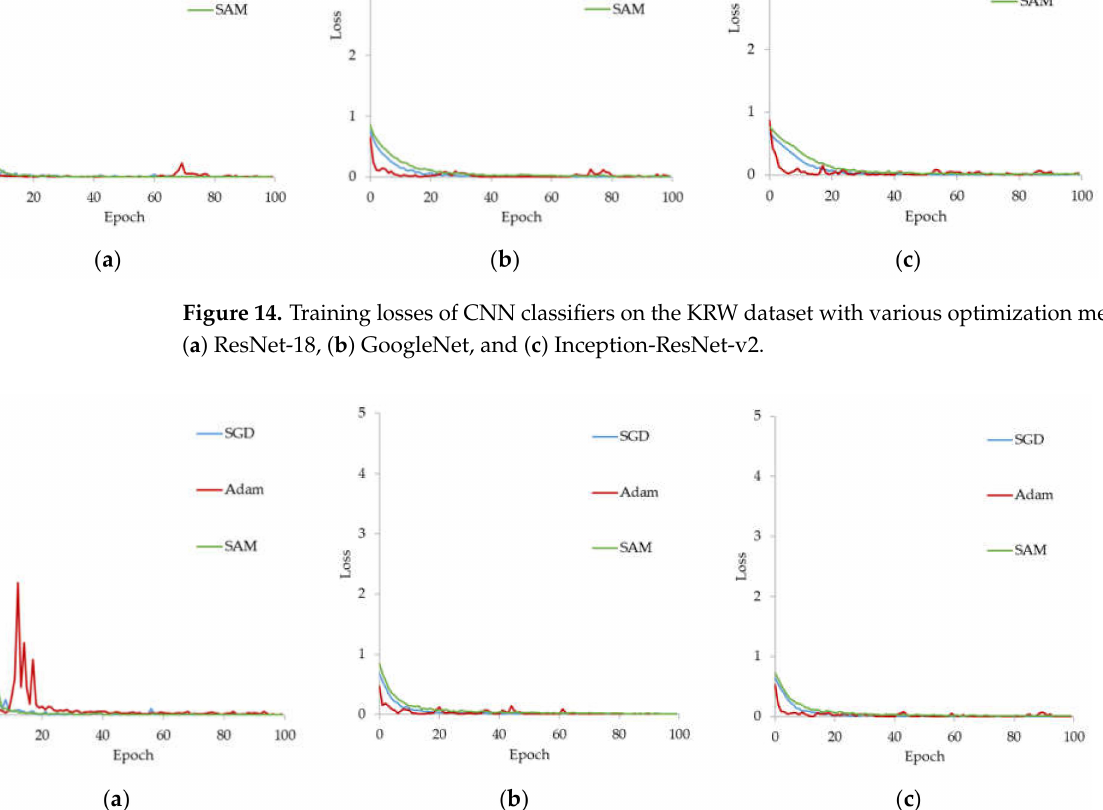
Using the trained CNN models, we tested the remaining (different) datasets and compared the results. In the first comparative experiment, we used YOLOv3 and a single additional CNN classifier to select the combination that yielded the best